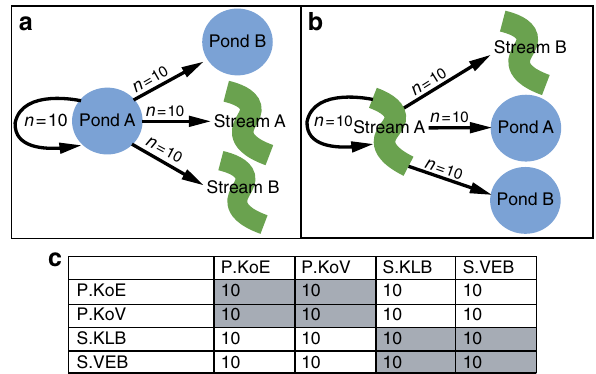
Figure 3 | Experimental design of the reciprocal transfer experiment. ( a ) Representation of transfer design for salamander larvae native to a pond site. ( b ) Representation of transfer design for larvae native to a stream site. ( c ) Experimental design cross-table with sample sizes; control groups are highlighted in greyed cells. P denotes pond sites and S denotes stream sites. Pond sites include, KoVand KoE and stream sites include, Vennerbach, VEB; Klufterbach,